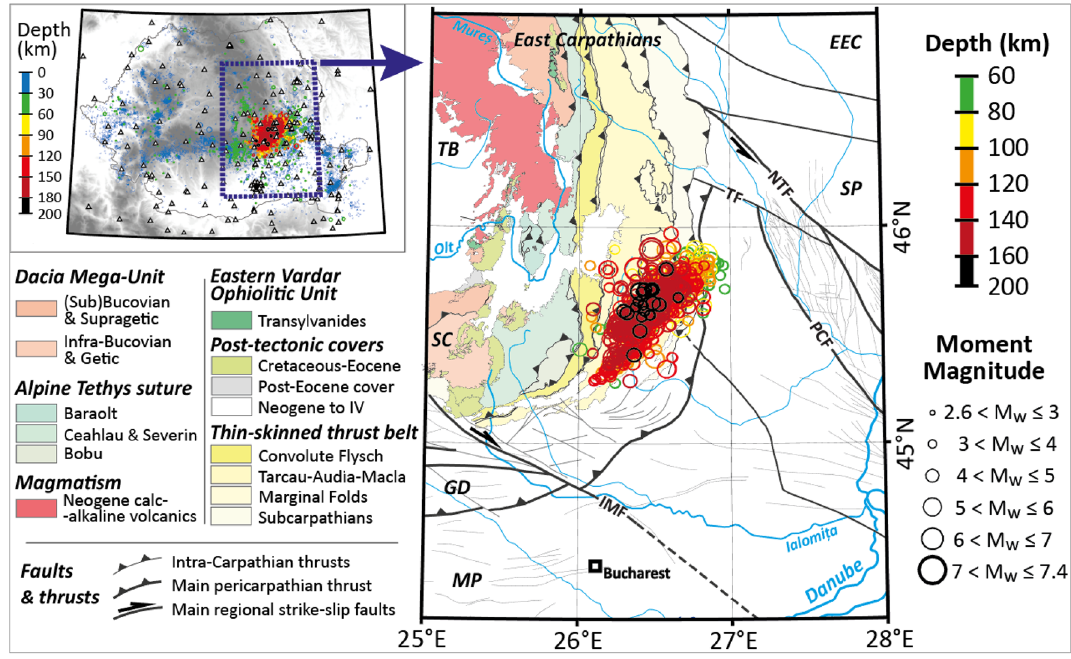
Figure 1. Synthetic map showing main tectonic units and intermediate-depth seismicity beneath Vrancea (modified after 9 ). The reduced dataset of 940 events for the 1929–2020 period is presented in Table S1. Hypocentral depths are indicated with the colour scale. The study area is presented with the purple contour on the mini-map. Map construction: tectonic features from 4 , epicentral locations from the BIGSEES